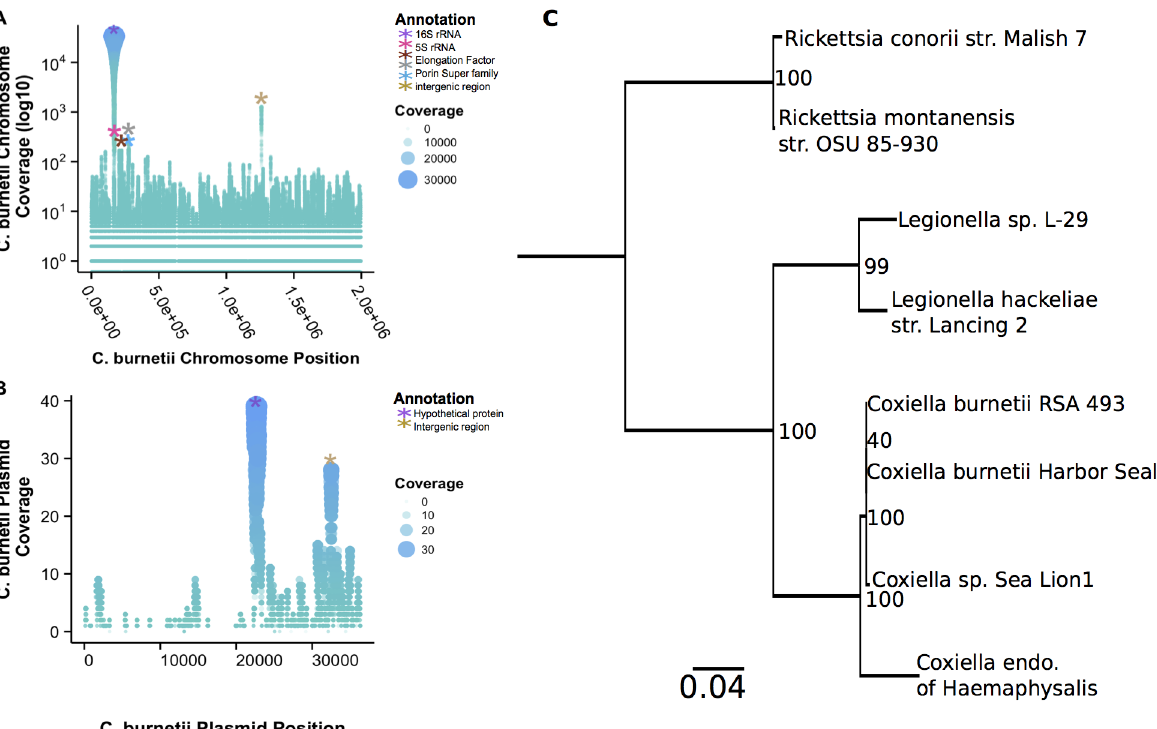
Fig 6. Scatter plot of change in coverage of each base pair position of RNA sequences from sample UCD6 that aligned to (A) Coxiella burnetii RSA 493 chromosome and (B) Coxiella burnetii RSA 493 plasmid pQpH1. (C) 16S RNA gene maximum likelihood tree with 1000 bootstrap values generated from the following bacterial gene sequences and their corresponding NCBI accession numbers: Rickettsia conorii strain Malish 7 (NR_074480.1), Rickettsia montanensis str. OSU 85 – 930 (NR_074472.1), Legionella sp. L-29 gene (AB856218.1) Legionella hackeliae strain Lancing 2 (NR_104894.1), Coxiella burnetii RSA 493(AE016828.2), Coxiella sp. SL 1 (GU797243.1), Coxiella endosymbiont of Haemaphysalis lagrangei isolate TSD16 (KC170756.1), and Coxiella burnetii Harbor Seal (KT894209).